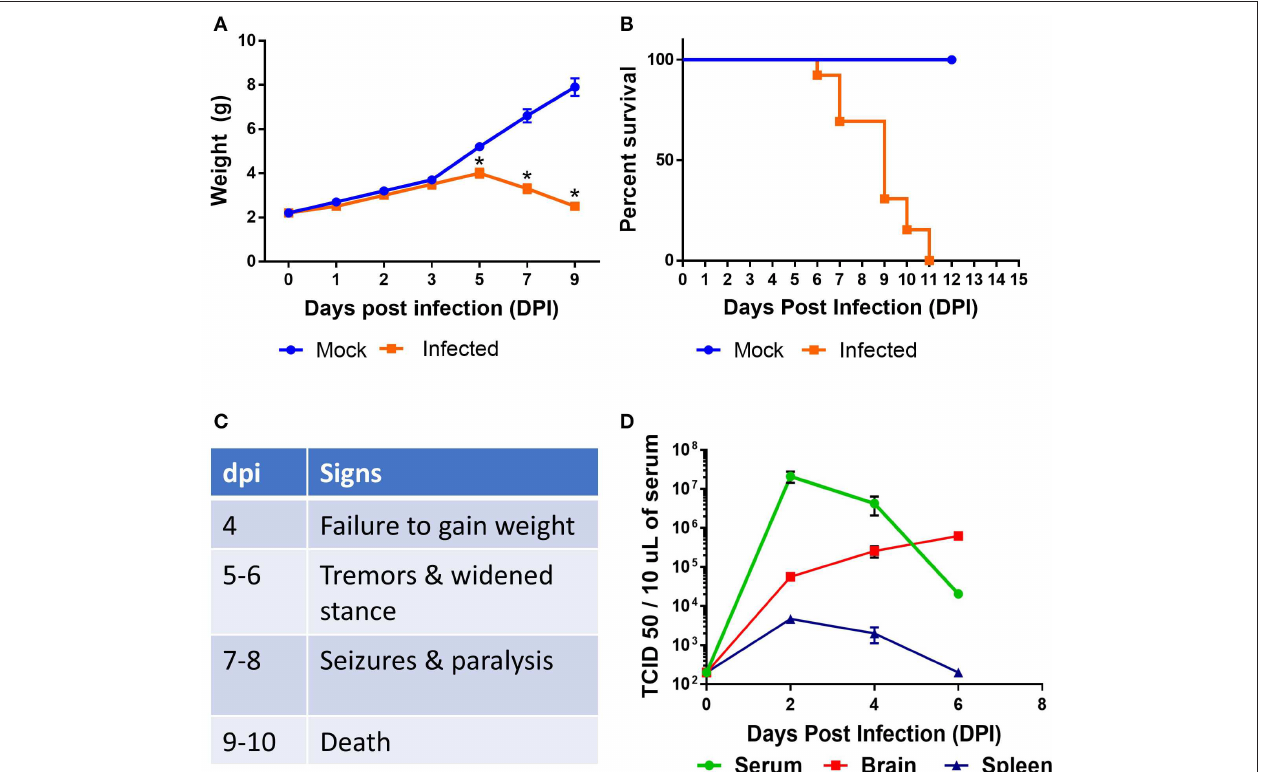
FIGURE 1 | Characterization of SINV pathology in neonatal mice. B6-WT neonatal mice were infected with wild type SINV on P3 and weight (A) and survival (B) were monitored. Uninfected animals were maintained as controls. (C) Table shows natural history of the disease. (D) Viral load in blood, spleen, and brain samples were measured at 2, 4, and 6 days post infection (dpi). Viral titers were measured by serial dilution of samples on Vero E6 cells and monitoring the cytopathic effect after 4 days. TCID 50 values were calculated using Reed and Muench method. Each group had at least six mice in two independent experiments.